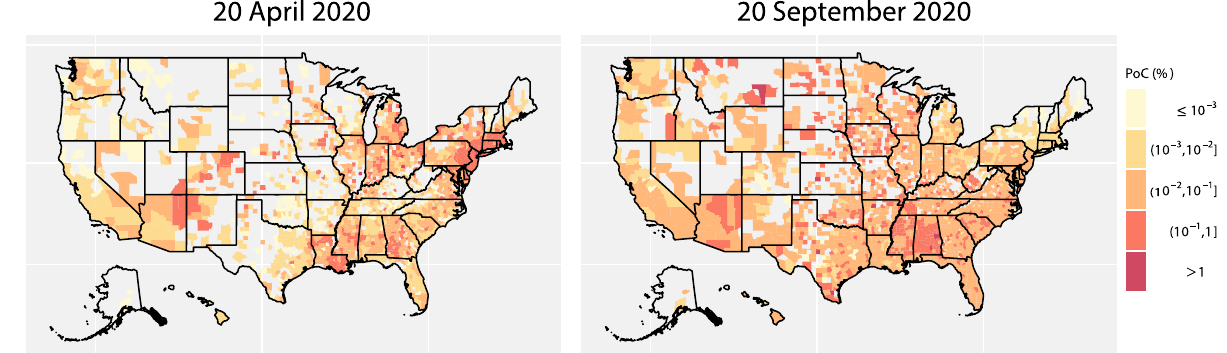
Figure 9. ( a ) The estimated probability of contracting SARS-CoV-2 at 1856 counties on 2020-04-20, and ( b ) at 2277 counties on 20 September 2020. The probability of contracting SARS-CoV-2 is truncated at 10 − 6 , whereas only 78 counties on 20 April and 45 counties on 20 September are below this level, respectively.